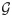
Spatial scale of the grid patterns.Example grid patterns obtained with different adaptation kernels K (Eq 2, top row) and different input tuning curves G (Eq 9, left-most column). For each choice of the functions K and G, the synaptic weights (left) and their corresponding Fourier spectra (right) at the end of the simulation are shown (t = 106 s). The synaptic-weight maps have different color scales (maximal values at the bottom-left corner). The red circles indicate the spatial frequency kmax of the weight patterns. Synaptic weights were obtained by simulating the average weight dynamics in Eq 16. Note that we used a larger enclosure (L = 2 m) as compared to the one in Figs 5 and 6 (L = 1 m). See Sec Numerical simulations for further details and parameter values.